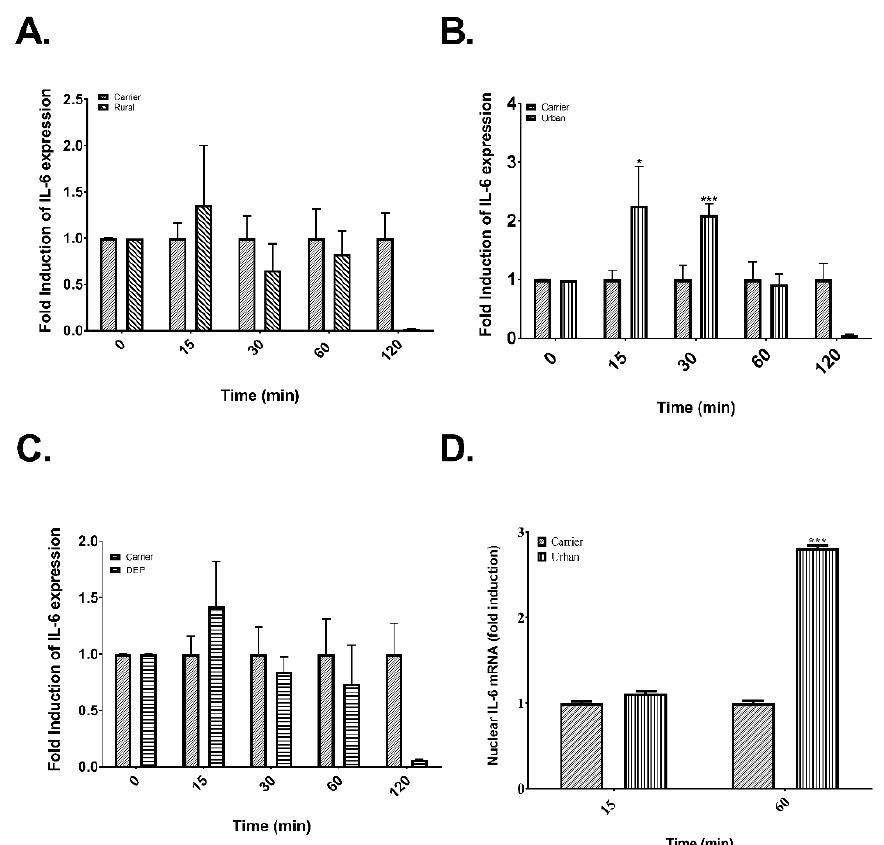
Figure 5. Post-transcriptional control and nuclear expression of IL-6 in cells exposed to rural and urban organic extracts from PR and DEP organic extract. ( A ) Time course of cells exposed to 25 µ g / mL of rural organic extract. ( B ) Time course of cells exposed to 25 µ g / mL of urban organic extract. ( C ) Time course of cells exposed to 10 µ g / mL of DEP organic extract. ( D ) Induction of the transcription rate of IL-6 transcript in response to urban organic extract exposure. Values are expressed as the mean ± SEM ( n = 3). * p ≤ 0.05, *** p ≤ 0.001 compared to carrier.